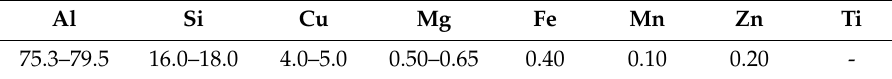
Table 1. Chemical composition of A390 alloy.